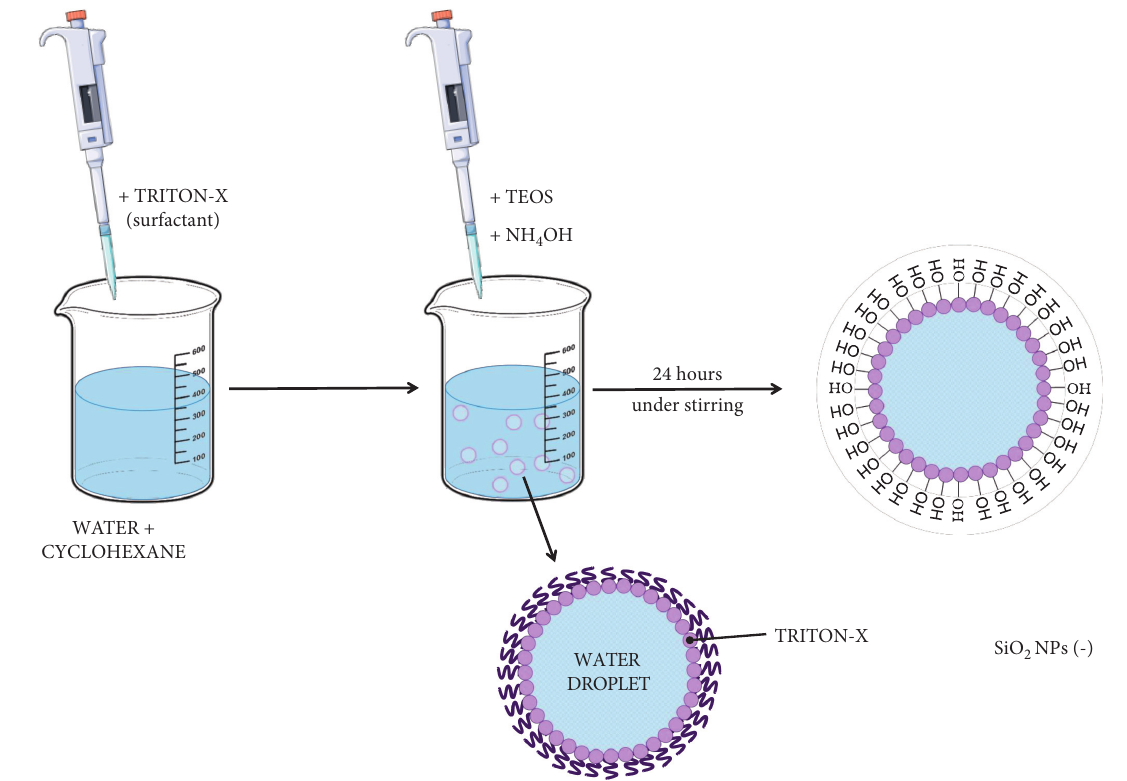
Figure 1: Schematic representation of SiO 2 NPs obtained by the microemulsion method.